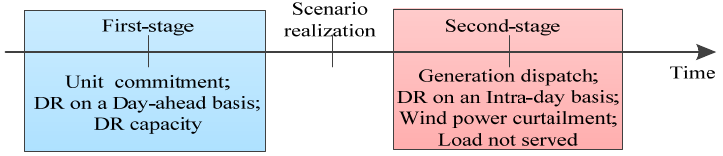
Figure 1. Sequence of decisions in the stochastic unit commitment (SUC) problem with flexibly scheduled demand response (DR).